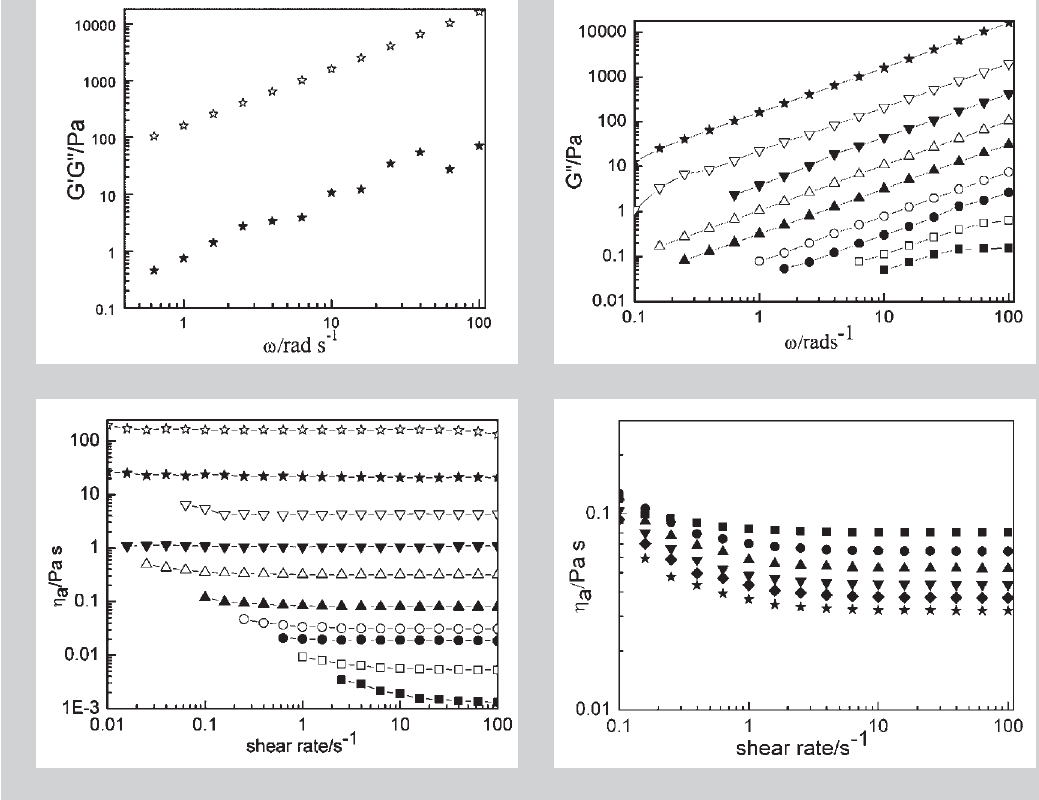
Figure 1 (left above): Plots of storage and loss moduli as a function of fre- quency at 25°C for pure RTIL ( (cid:3) G’, (cid:4) G”). Figure 2 (right above): Loss modulus G’’ of solu- tions at 25°C versus frequen- cy for binary RTIL/EtOH mix-